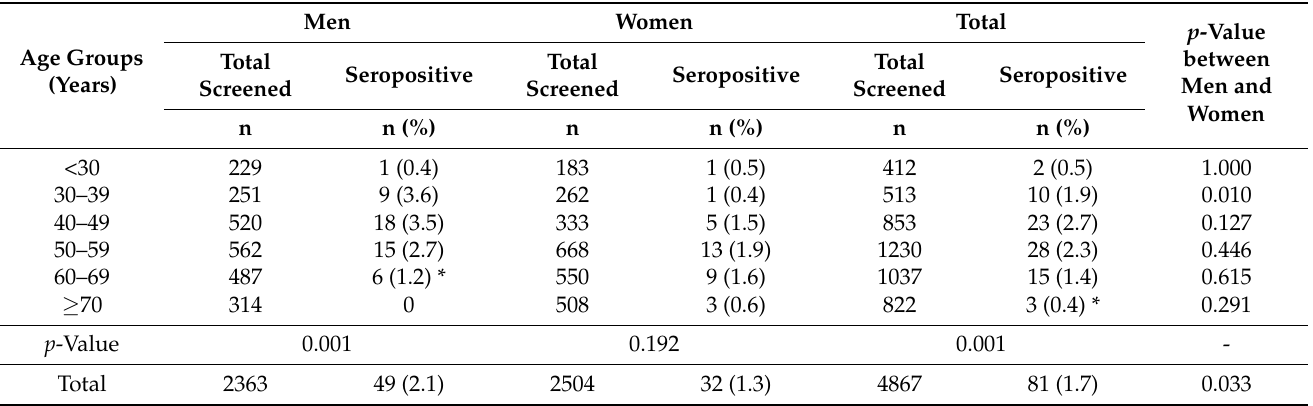
Table 2. Seroprevalence of hepatitis C virus infection among the people screened at the primary health care center in Klaipeda.